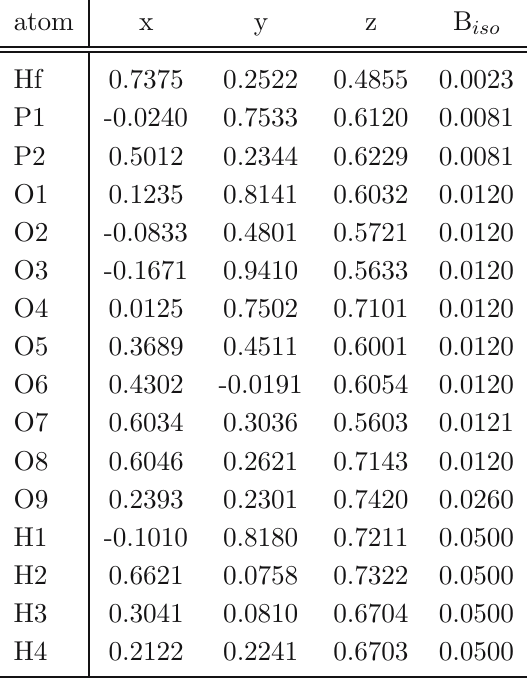
Table 5 The positional and thermal parameters of atoms in α -hafnium phosphate